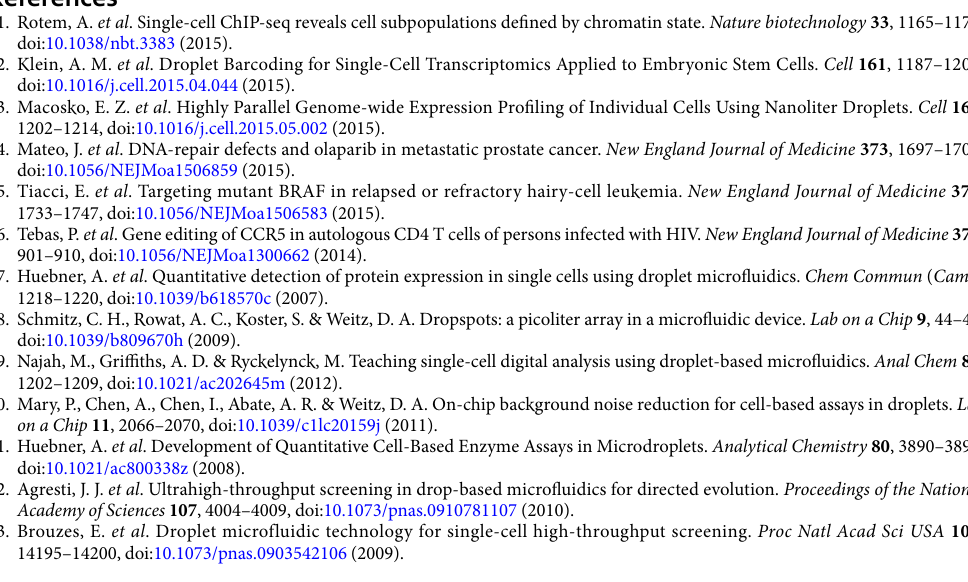
These values are identified by the condition that the precedent derivative point is positive and successive point is negative. For elimination of the noise point, a minimum threshold for detecting these cells is applied (Supplementary Fig. S1f). The number of cells in every sequence can be calculated (Supplementary Fig. S1g). The complete MATLAB script is shown in Supplementary Fig. S4. Cell culture. HL60 cells were cultured in RPMI-1640 medium (LifeTechnologies) supplemented with 10% of heat-inactivated Fetal Calf Serum (FCS) (lot n°S11060S181, Dominique Dutscher) contain- ing Penicillin-Streptomycin (50 UI/ml and 50 µ g/ml) (GIBCO ® ). HL60 cells were seeded every 2–3 days at 100,000 cells/mL in 5 mL in 25 cm 2 flasks (BD Falcon). H1975 cells were cultured in RPMI-1640 medium supple- mented with 10% Fetal Calf Serum (FCS) (lot n°S11060S181, Dominique Dutscher) and 1% Sodium Pyruvate and Hepes (Lifetechnologies). H1975 cells were seeded twice a week at 300,000 cells/mL in 20 mL in a 75 cm 2 flask (BD Falcon). All cell lines were incubated at 37 °C and 5% CO 2 . Bacteria culture. 5 mL of Luberia Broth (ThermoFisher) supplemented with 50 µ g/mL of Kanamycin (ThermoFisher) was inoculated with one colony of BL21(DE3) cells transformed with the plasmid pET_eGFP. After overnight growth with agitation at 37 °C, the culture was diluted with fresh medium to reach an absorbancy at 600 nm of about 0.3 and expression was induced by the addition of 0.2 mM Isopropyl β -D-thiogalactoside (IPTG) (ThermoFisher). After 4 hours, cells were diluted to reach the desired dilution. We have assumed that a culture of OD600 of 1.0 equal 5 × 10 8 cells/mL. Plasmid description. A sequence optimized gene for E. coli corresponding to eGFP (Genbank gi: 7453572; from MVS. to LYK) followed by a stop codon (TAA) and flanked by suitable restriction sites (5 ′ - Nde I and 3 ′ - Xho I) was ordered from Sigma/Genewiz. The synthetic gene and pET28a were digested by Nde I and Xho I and the puri- fied fragments were ligated to create pET_eGFP. Microfluidic chip fabrication. Microfluidic devices were prepared from poly (dimethylsiloxane) (PDMS) by standard soft-lithography techniques 1 . A mold of SU-8 resist (MicroChem) was fabricated on a silicon wafer (NEYCO) by UV exposure (MJB4 contact mask aligner; SUSS MicroTec) through a photolithography mask (Selba) and developed (SU-8 developer; Micro-Chem). Curing agent was added to the PDMS base (Sylgard 184 silicone elastomer kit; DowCorning) to a final concentration of 10% (w/w), mixed, and poured over the mold. Following degassing for several minutes and crosslinking at 75 °C for one hour, the PDMS was peeled off the mold and the input and output ports were punched with a 0.75 mm diameter biopsy punch (WPI). Particles of PDMS were cleared from the ports using Scotch tape, rinsing with Isopropanol and drying with pressur- ized nitrogen. The structured side of the PDMS slab was bonded to a 75 × 50 × 1.2 mm glass microscope slide (Corning) by exposing both parts to an oxygen plasma (PICO, Diener) and pressing them together. Finally, an additional hydrophobic surface coating was applied to the microfluidic channel walls by injecting the completed device with Aquapel glass treatment (PPG Industries) and then purging the liquid with nitrogen gas. For the electro-microfluidic chips the PDMS device is plasma bonded to the non-conductive side of a 75 × 50 × 1.1 mm Indium Tin Oxide glass (ITO, Delta Technologies). The conductive side of the ITO glass is used as a counter elec- trode. Electrodes are incorporated into the system by filing the micro channels with a low-melting point solder (Indalloy 19, Indium